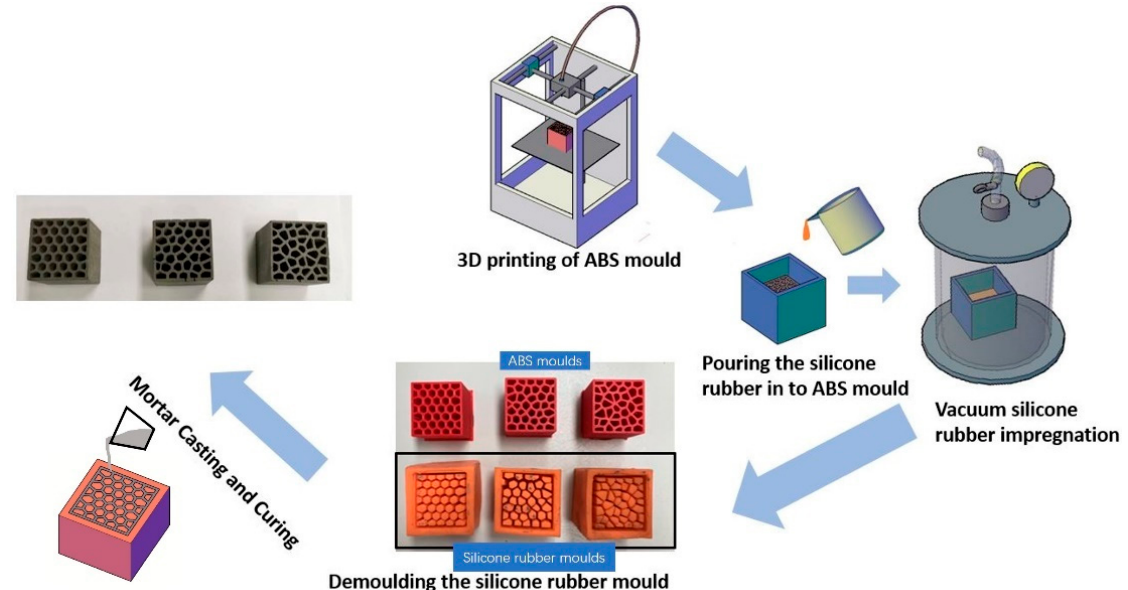
Table 2. Specimen characteristics.